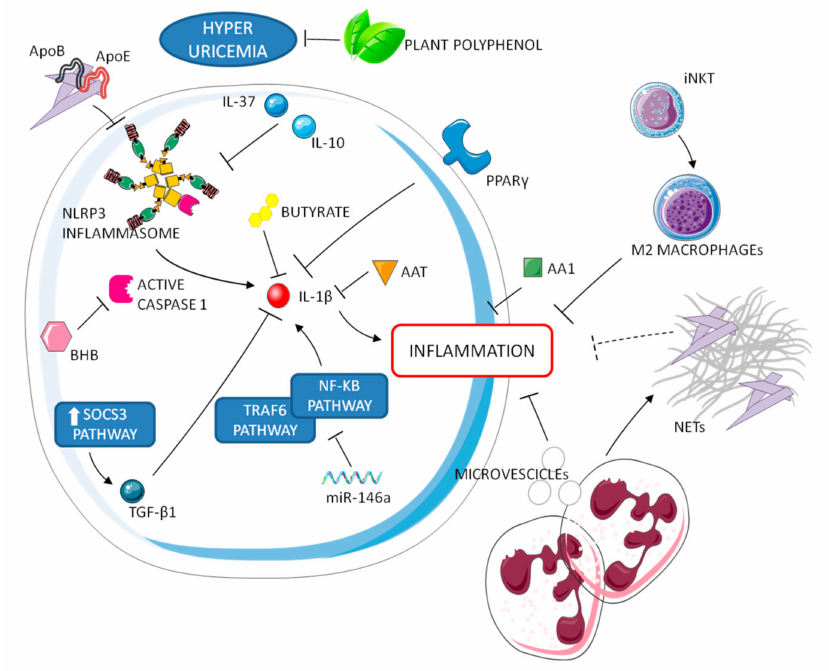
Figure 2. Resolution processes of gouty inflammation. Negative regulators of inflammasome and IL-1 operate in synergy with neutrophils and M2 macrophages to attenuate the inflammatory